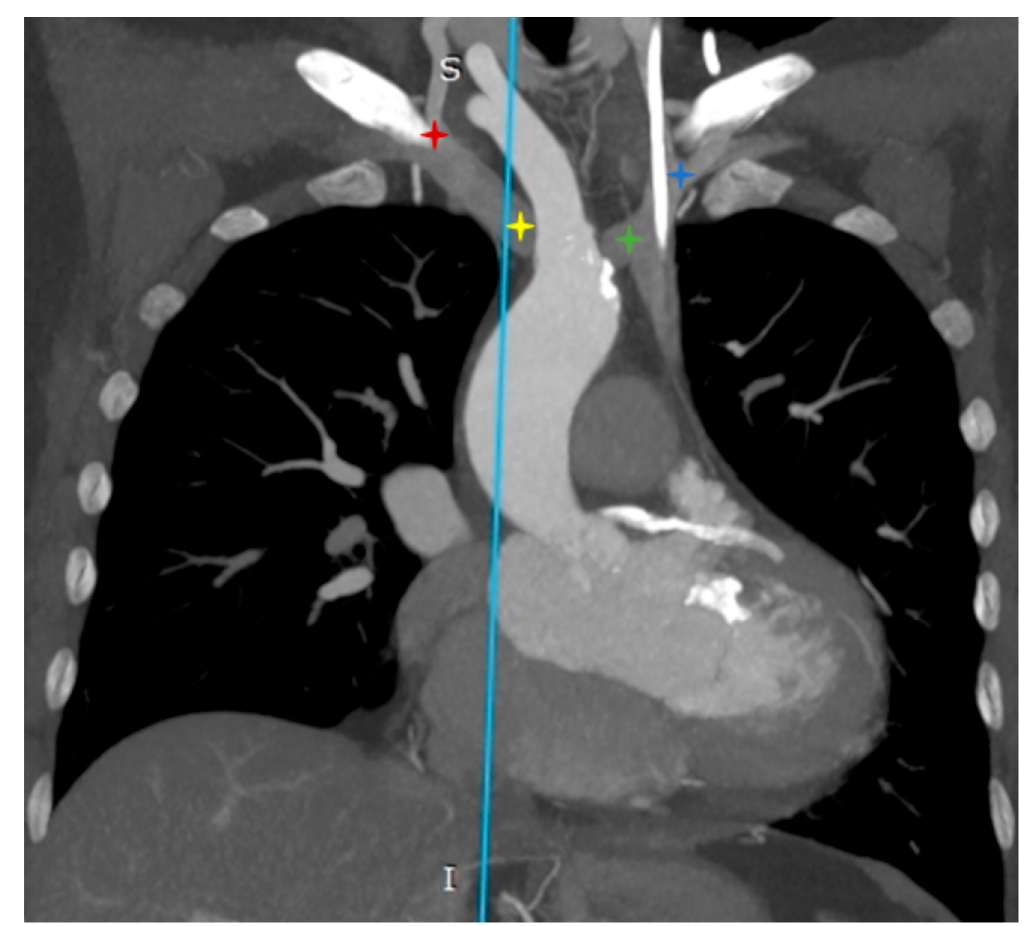
Figure 2. Confluence of the brachiocephalic veins to the left superior vena cava. Discussion: Persistent left superior vena cava is a developmental anomaly of venous circulation occurring in about 0.5% of the general population, of which about 0.3% are healthy people and 4.3% are people with congenital heart defects. Even more rare are cases with persistent left SVC in the absence of right SVC, and they account for about 0.09% to 0.13% of patients with congenital heart disease. Defects that coexist with this anomaly include situs inversus or situs solitus [8].